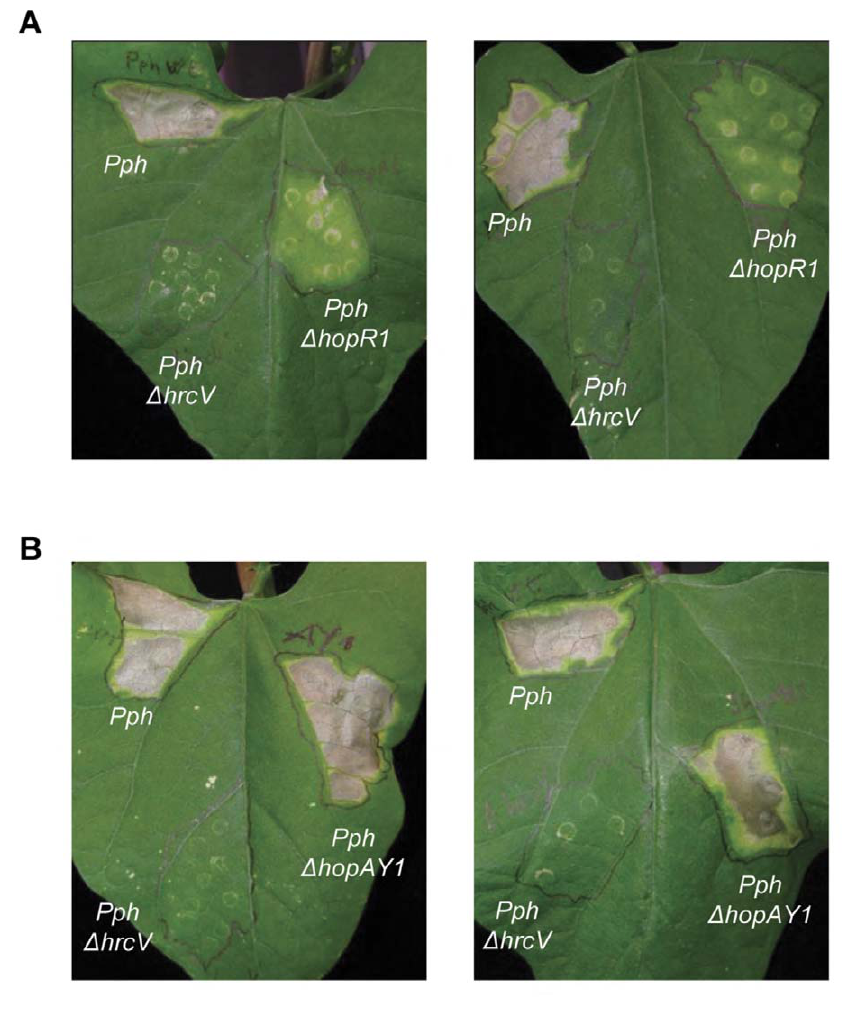
Figure 1. Disease symptoms in bean plants. Plants were infiltrated with 10 6 cfu/ml, and symptoms documented at 7 days post-inoculation (dpi). A . Virulence symptoms caused by Pph D hopR1 are significantly reduced in relation to wild type ( Pph )-induced symptoms. B . Pph D hopAY1 causes similar symptoms to those induced by wild type ( Pph ). The experiment was carried out thrice with similar results. Images show representative results.